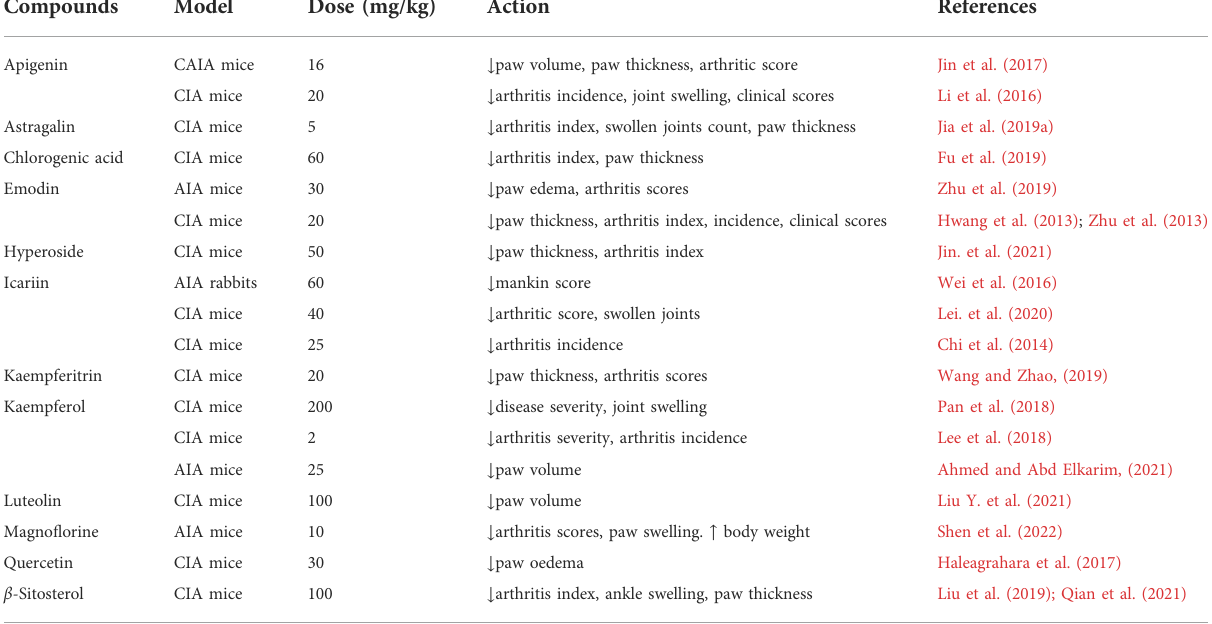
TABLE 3 The anti-arthritis effect of compounds from EH for the treatment of RA in the animal models.